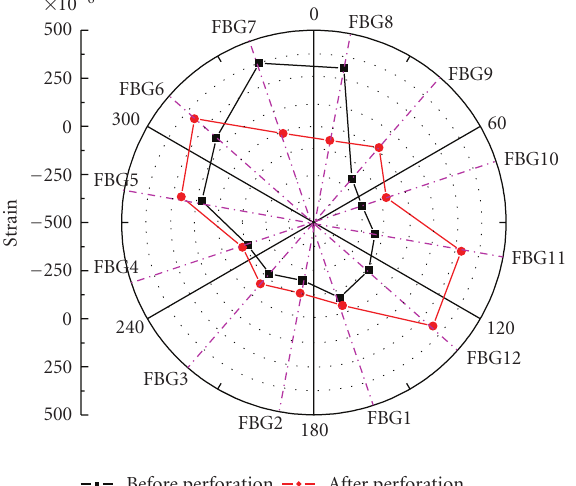
Figure 16: The distribution of casing pipe circumferential stress measured by FBG sensors.